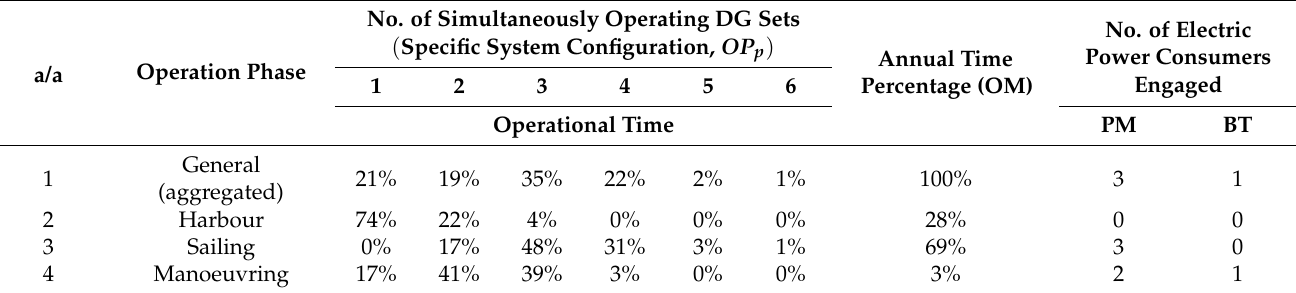
Table 4. Operational profile for the investigated cruise